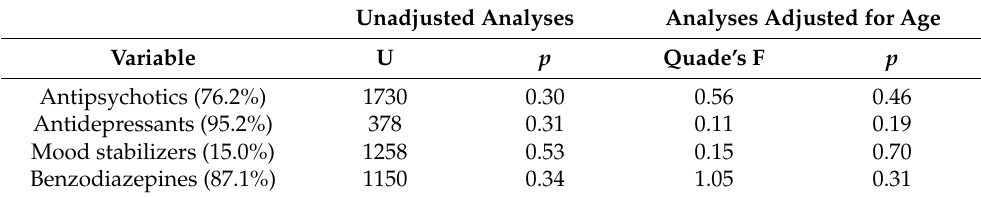
Table 5. Association between LTL and medication